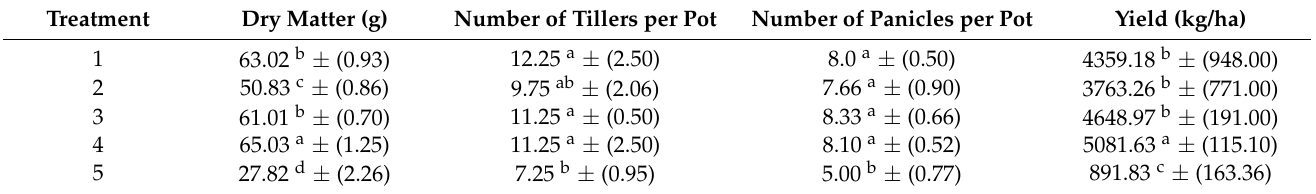
Table 2. Effect of different treatments on the growth and yield parameters of rice cultivated in pots. Treatment